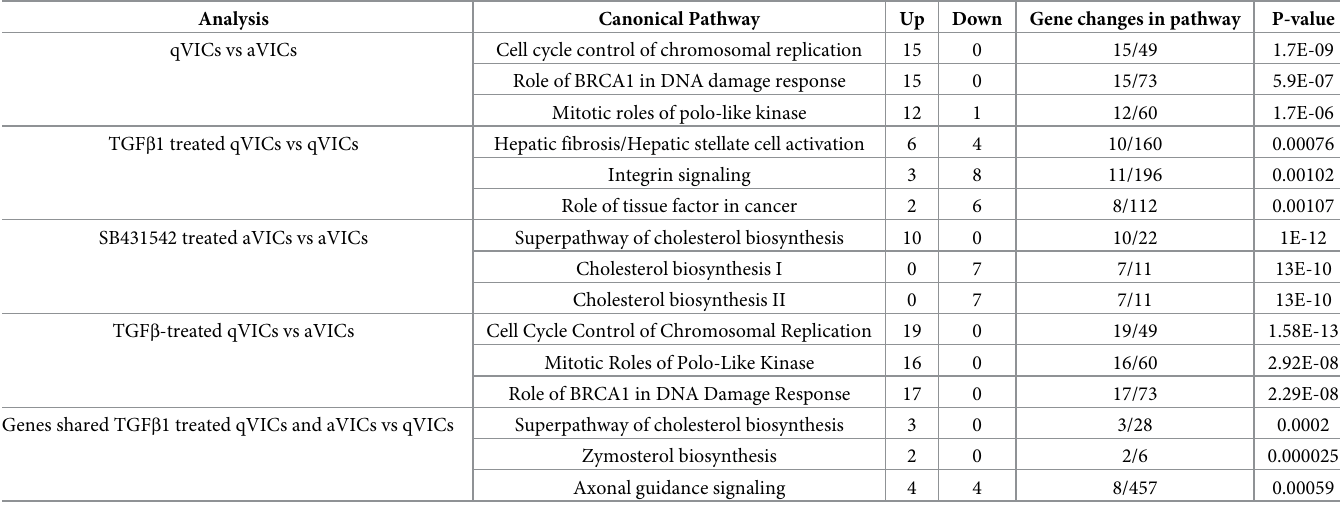
Table 2. Canonical